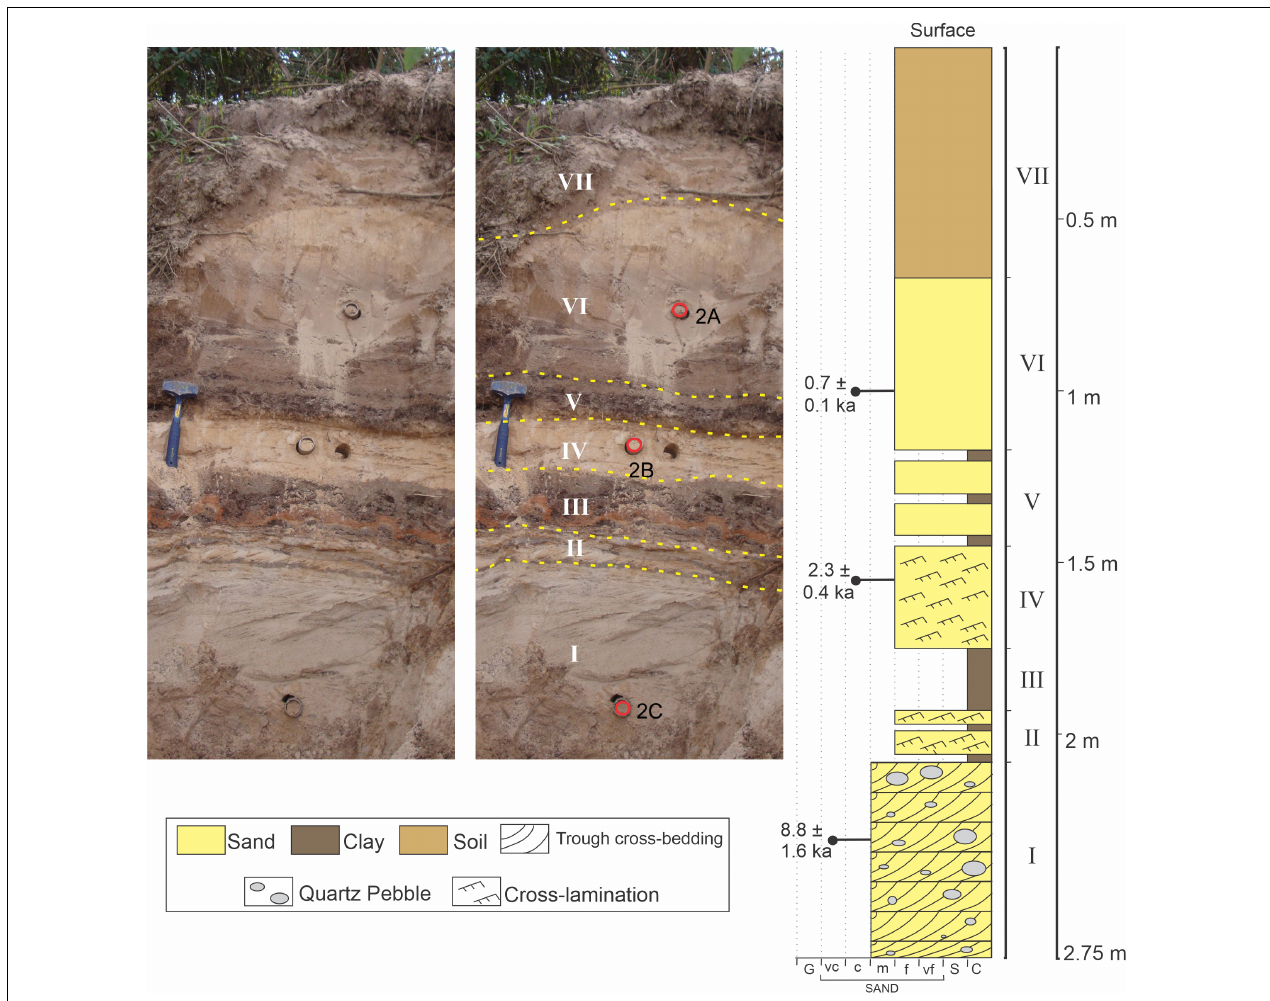
FIGURE 6 | Sedimentary profile described in point 2, located at the margin of Aguapeí River, corresponding to Unit 4. This outcrop presents, from base to top: medium sand, with through cross stratification, with well sorted, well rounded grains and clay intraclasts ranging from 1 to 15 cm; fine sand with cross laminations and clay levels in the foresets; clay with levels of deformed fine sand; fine sand with cross laminations with clay in the foresets, centimetric intercalations of fine sand with clay matrix; fine massive sand and soil from alluvial